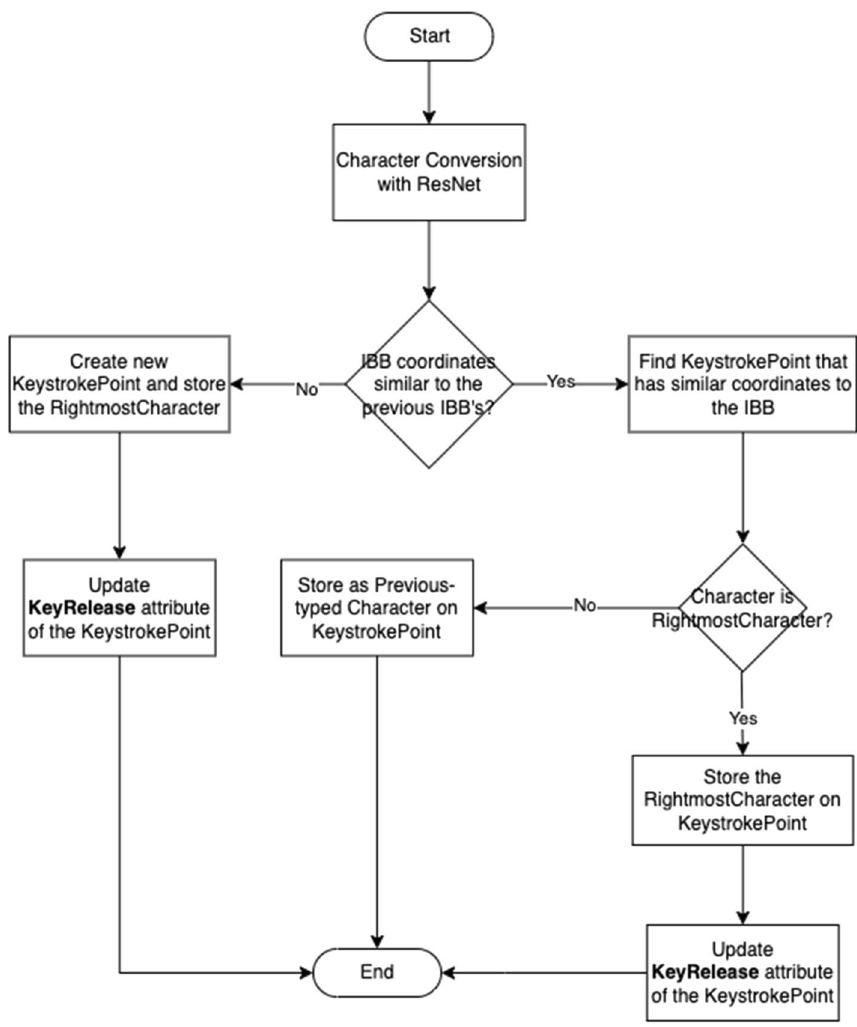
Fig. 8 Storing KUnit into KeystrokePoint